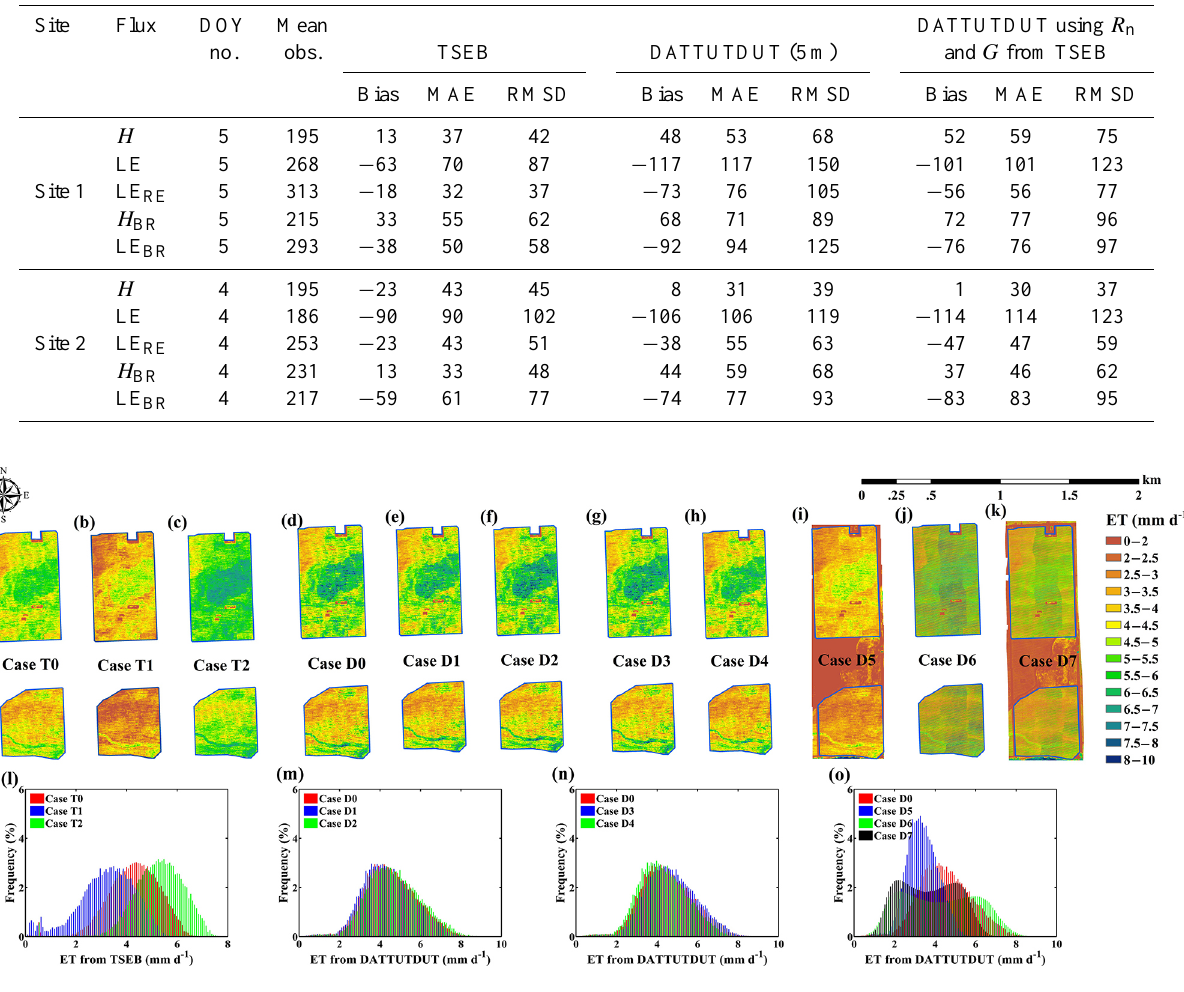
Figure 10. Comparison of the ET patterns and frequency distributions generated by TSEB and DATTUTDUT under the sensitivity tests described in Table